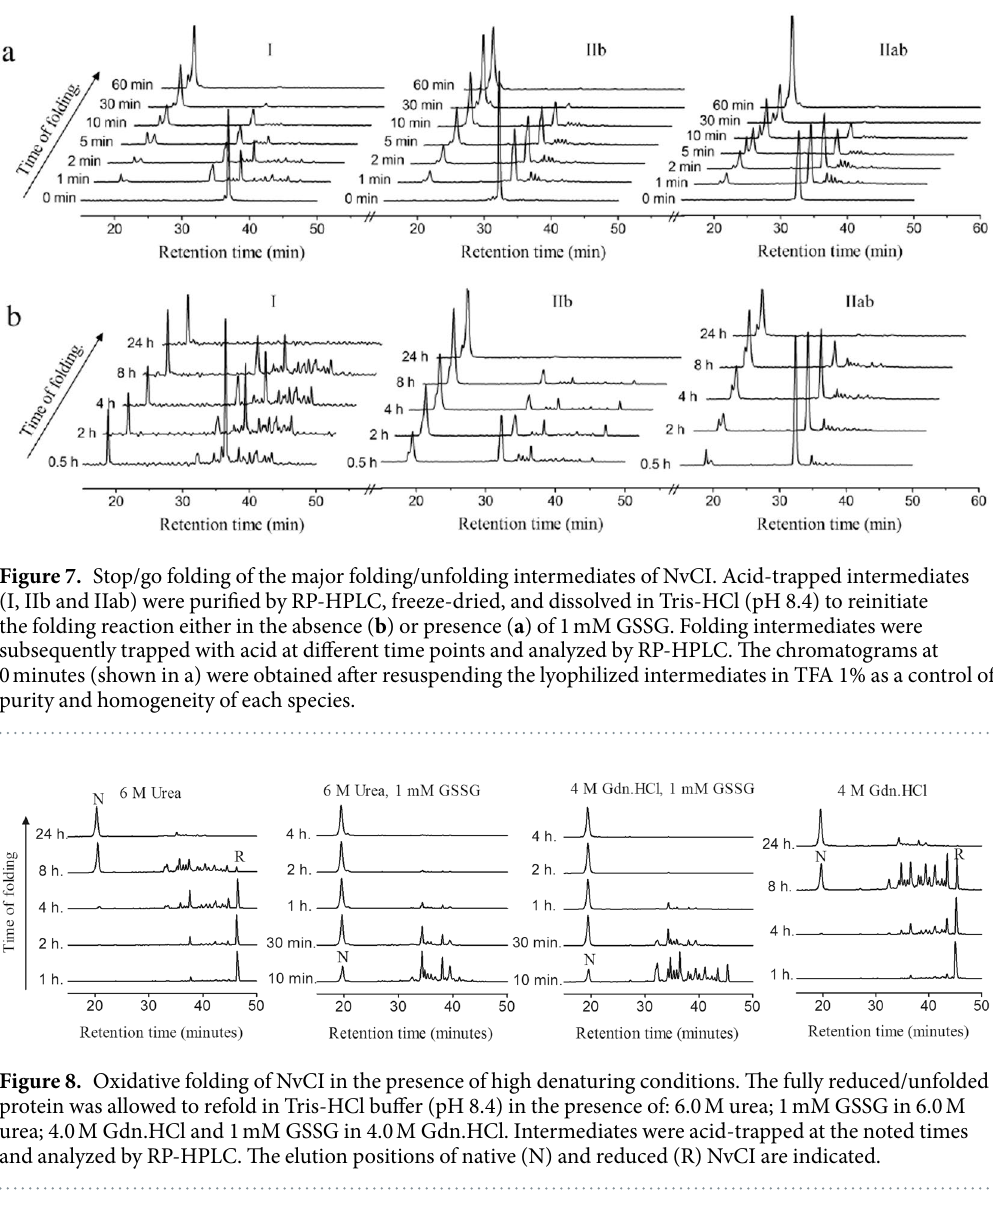
than the native inhibitor.